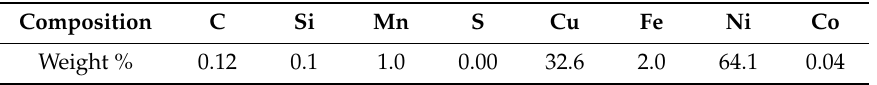
Table 1. Chemical composition of Monel 400.